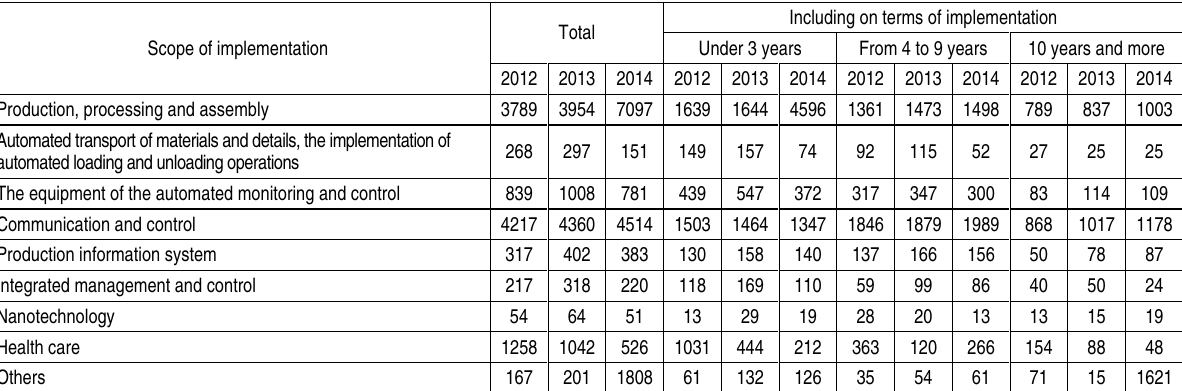
Table 1 (cont.). The dynamics of the use of advanced technologies in the context of scope and the duration of implementation